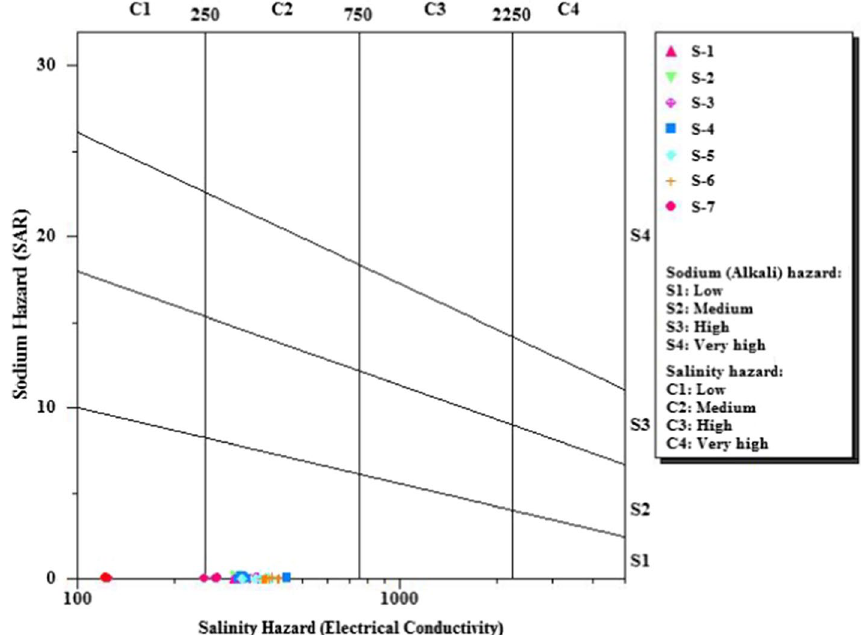
Fig. 3 United States Salinity Laboratory (USSL) diagram ( SAR Vs. Salinity Hazard) showing the hazard level of sodium and salinity of irrigation water at high altitude (Leh, Ladakh, India) (after Richards,